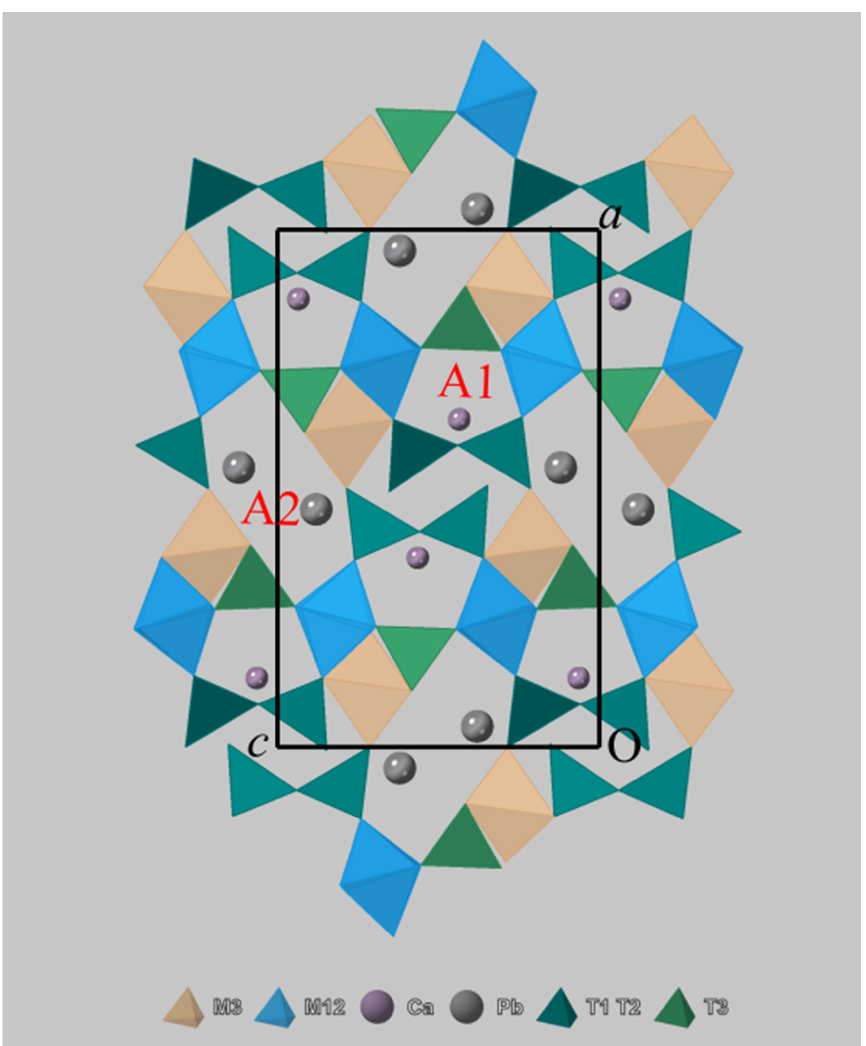
Figure 6. Polyhedral representation of zoisite-(Pb) structure as seen along [010]. A2 cavities host Pb, whereas Ca is present in A1 cavities. Crystal structure representations were obtained through the CrystalMaker software (CrystalMaker Software Ltd.).